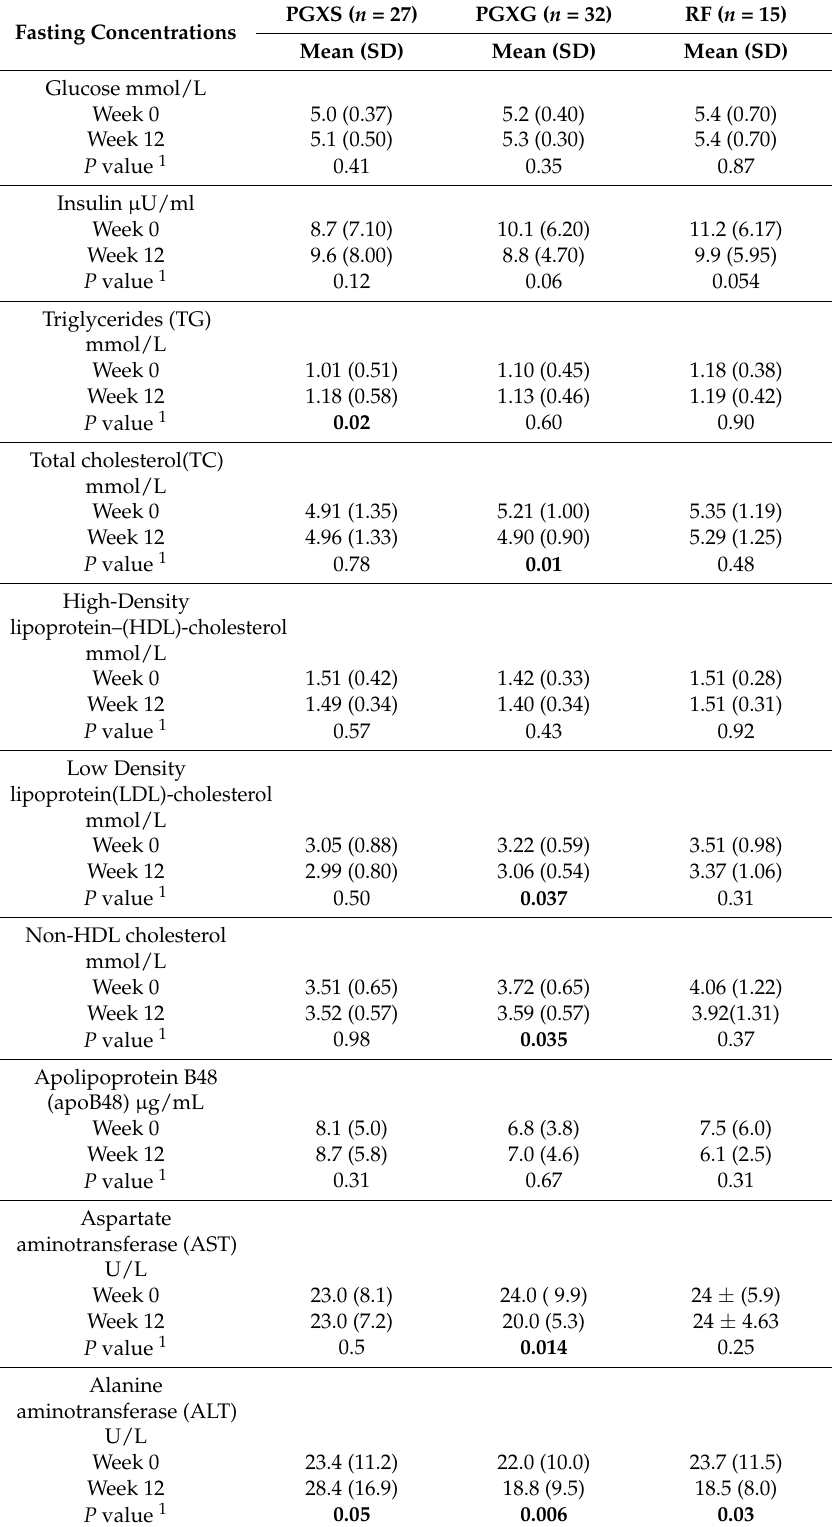
Table 2. Blood profiles for study participants at week 0 and week